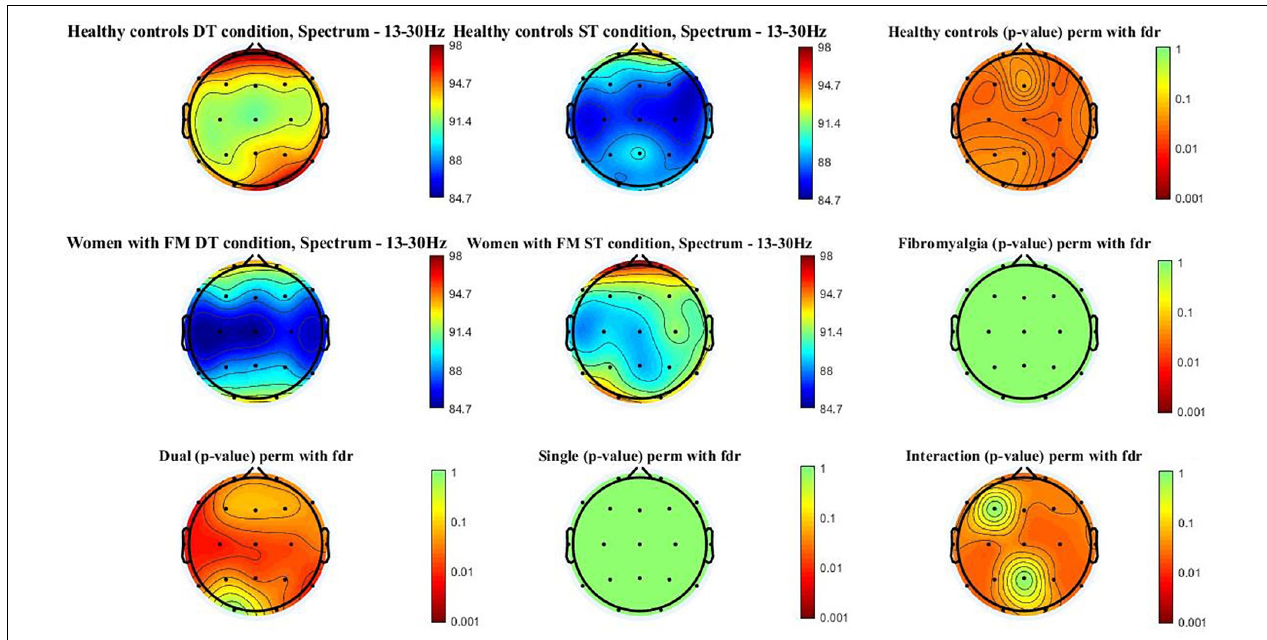
FIGURE 3 | Beta power spectrum (13–30 Hz) topographic maps in women with FM and healthy controls. Differences were only located ( p < 0.05) between ST and DT conditions in healthy controls and between healthy controls and women with FM in the DT condition. In addition, the interactions group*condition is significant in the following scalp locations: frontal (Fp1, Fp2, Fz, F4, F7, and F8), central (Cz, C3, and C4), temporal (T3, T4, T5, and T6), parietal (P3 and P4), and occipital